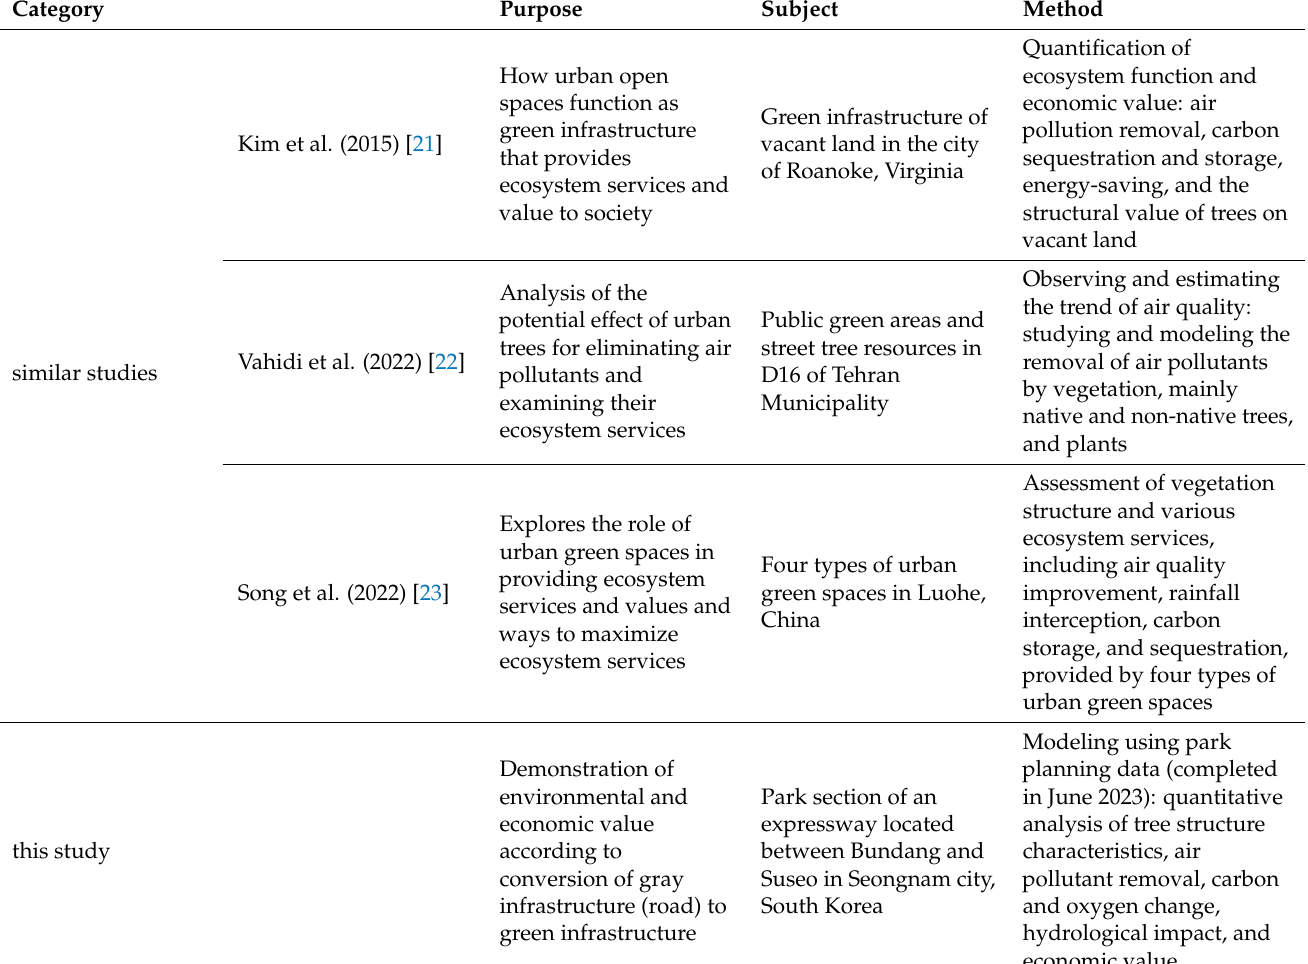
Table 6. Comparison of similar studies using the i-Tree Eco